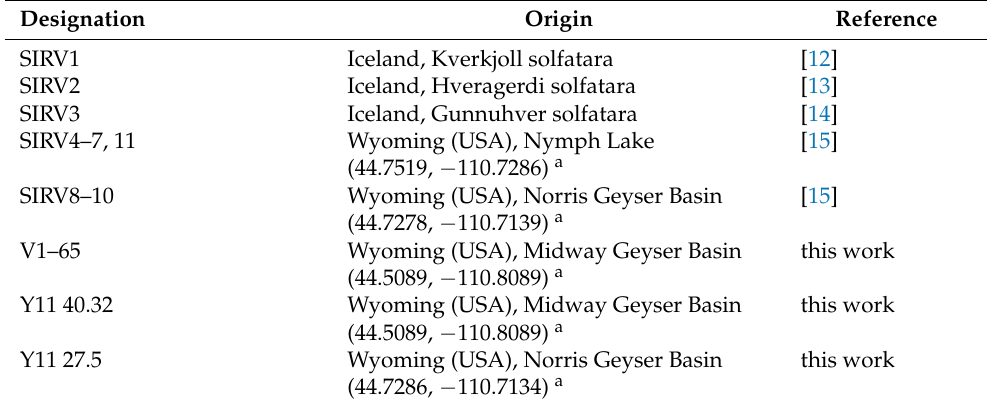
Table 1. Summary of Virus